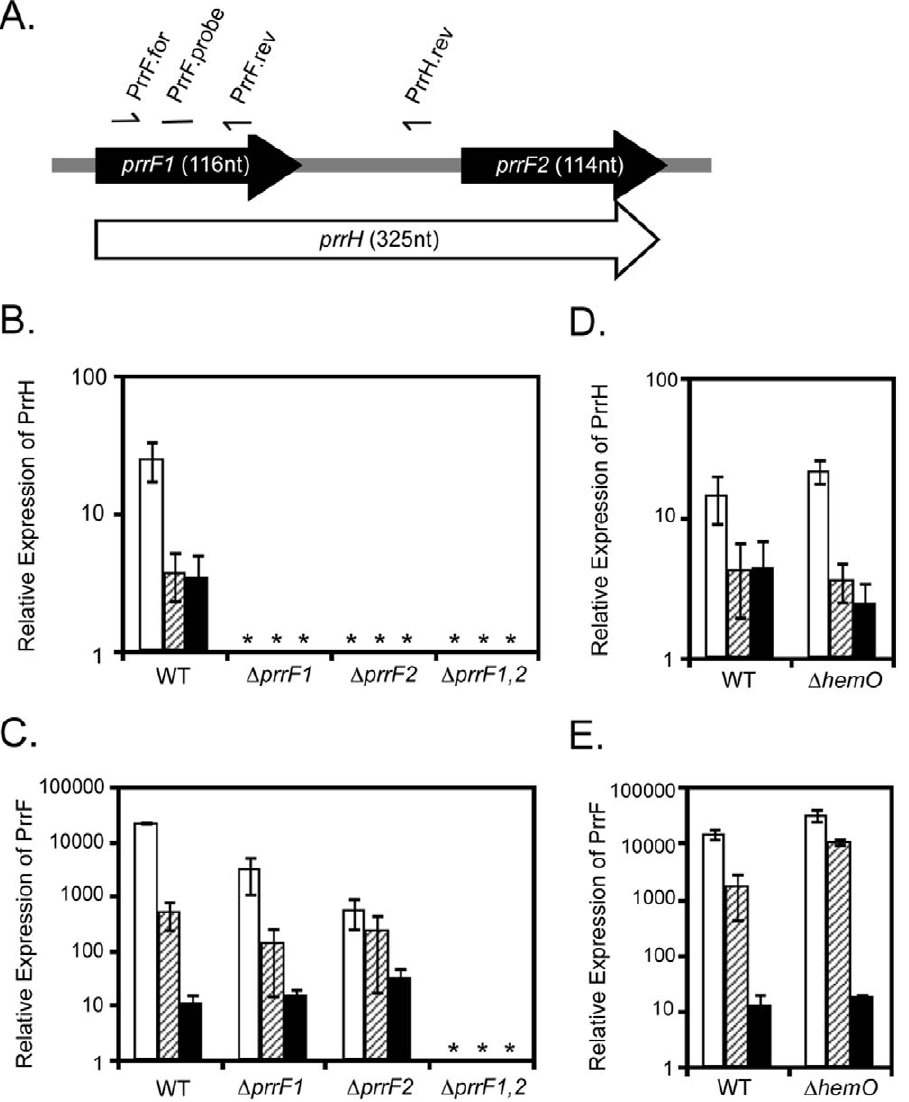
Figure 3. Quantification of PrrF and PrrH expression. A. Map of the PrrF-PrrH coding region showing the location of the primers and probes used for qRT-PCR. B-E. RNA was isolated from the indicated strains grown for 18 hours in CM9 + 1% glycerol with no added iron (white bars), 40 m M hemin (hatched bars), or 100 m g/ml FeCl 3 (black bars) and used for qRT-PCR analysis of the PrrH (B, D) and PrrF (C, E) RNAs as described in the Materials and Method. Error bars represent the standard deviation of three independent experiments. Asterisks (*) indicate expression was below detection levels.